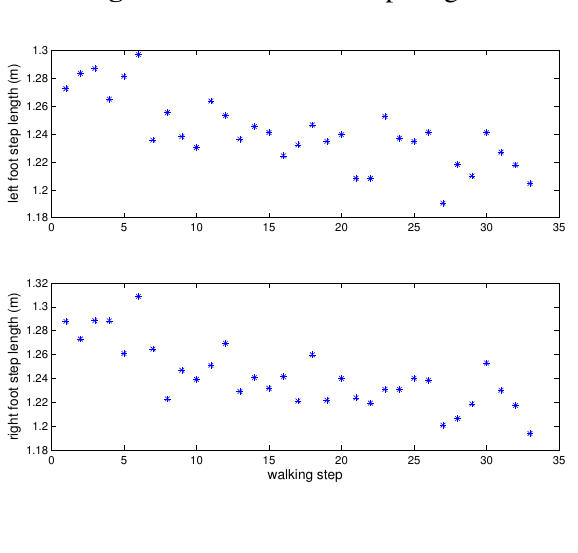
Figure 13. Estimated Step